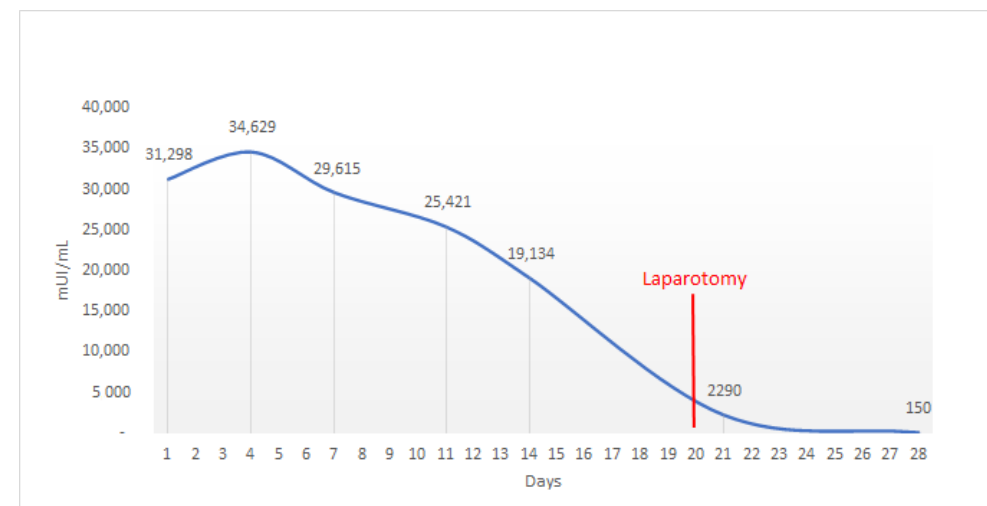
Figure 4. ꞵ -hCG serum level during hospitalization. On day 1 first methotrexate dose was adminis- tered, the second one was given on day 7.